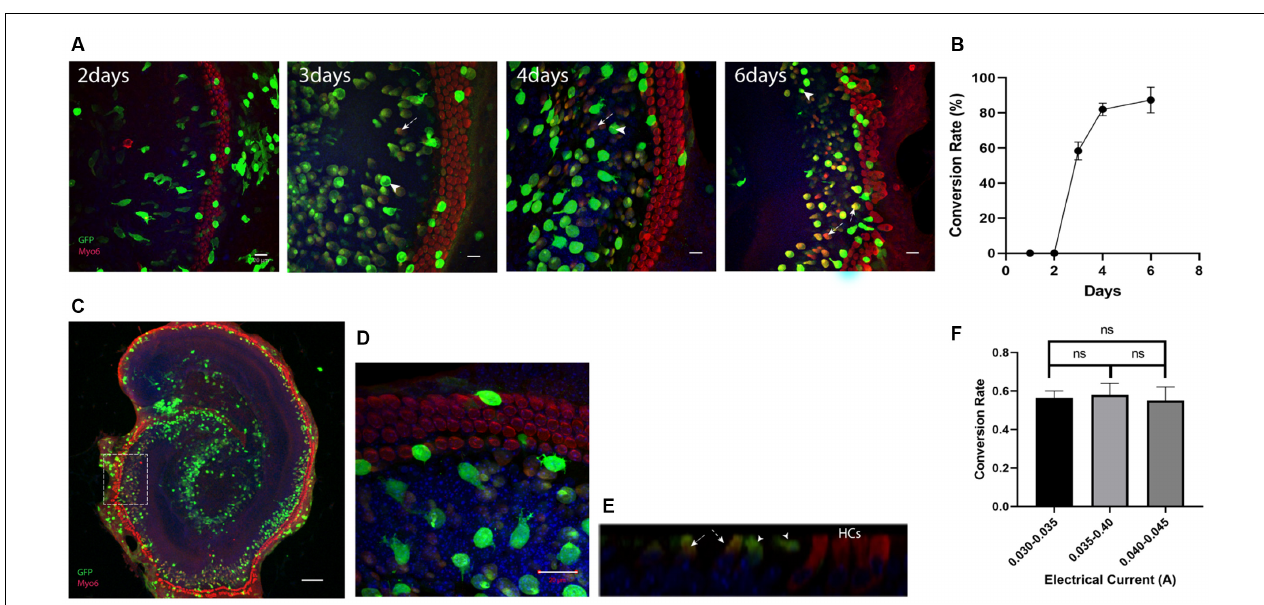
FIGURE 2 | Ectopic expression of Atoh1 leads to the new Myosin6 expressing cells in lateral GER. (A) Morphological images of Atho1-eGFP plasmids transfected explants at 2, 3, 4, and 6 days after the electroporation. The image for 6th day is an enlarged image of the white square in panel (C) . GFP+ cells indicate the transfected cells and GFP+/Myo6+ cells in lateral GER indicate the Myo6 expressing cHCs after the ectopic expression of Atoh1. There were no cHCs 2 days after the electroporation, more cHCs were observed from day 3 to day 6 , and the transfected cells were gradually getting closer to endogenous HCs. (B) The percentage of GFP+/Myo6+ cells vs. all GFP+ cells in lateral GER (conversion rate) gradually increases from day 2 to day 10 after the electroporation. (C) Typical Atoh1-eGFP plasmid transfected cochlear explant showing most of the transfected cells were localized in the lateral GER, Scale bar = 100 µ m. High-resolution image (D) and ortho image (E) showing the transfected epithelium cells. (F) The conversion rate of transfected cells with different electric currents. The arrows pointed to GFP single positive cells which are the transfected cells that failed to transdifferentiate, the arrowheads pointed to the GFP, Myosin6 double-positive cells which are the cHCs. Scale bar = 20 µ m. ns, not significant by unpaired two-tailed Student’s t -test. Results are presented as the mean ±